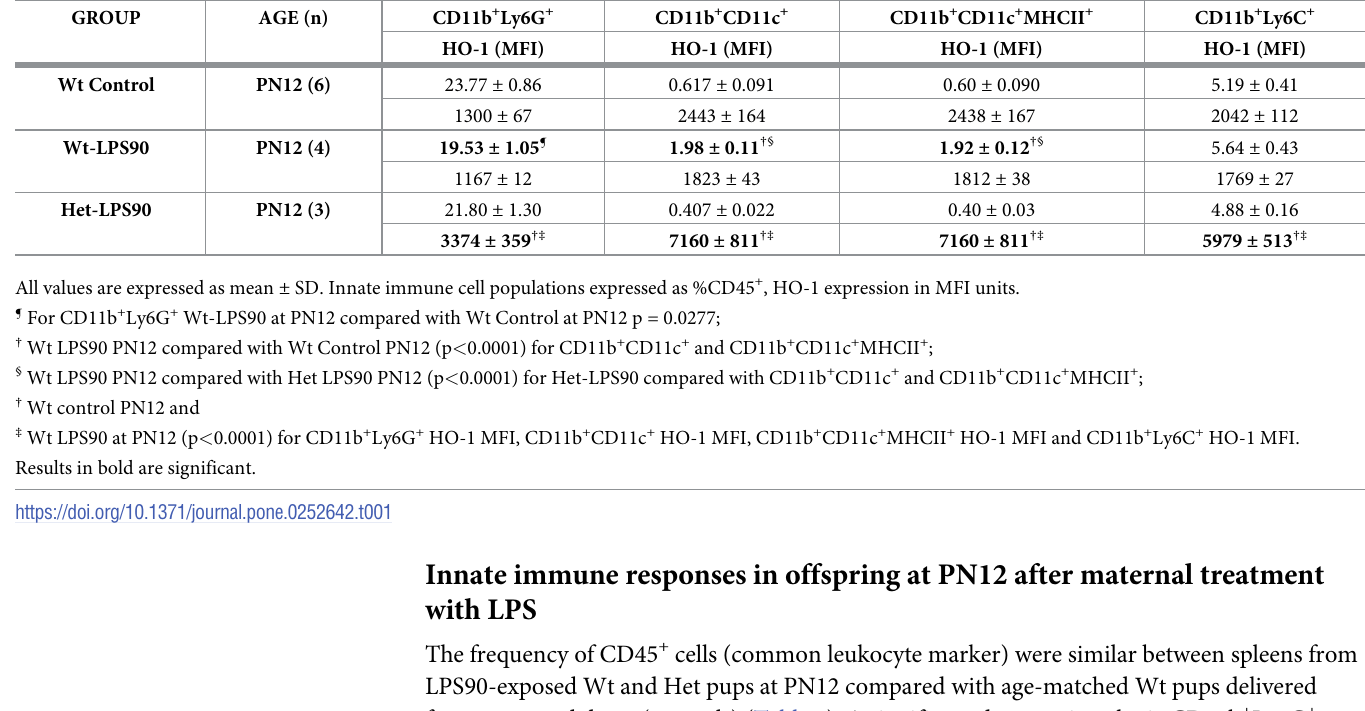
Table 1. Innate immune cell populations in spleens of Wt and Het offspring at PN12 from mothers treated with or without LPS at E15.5. GROUP